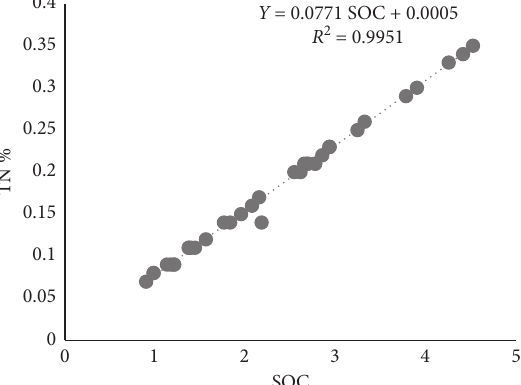
Figure 5: Linear regression between SOC and TN.